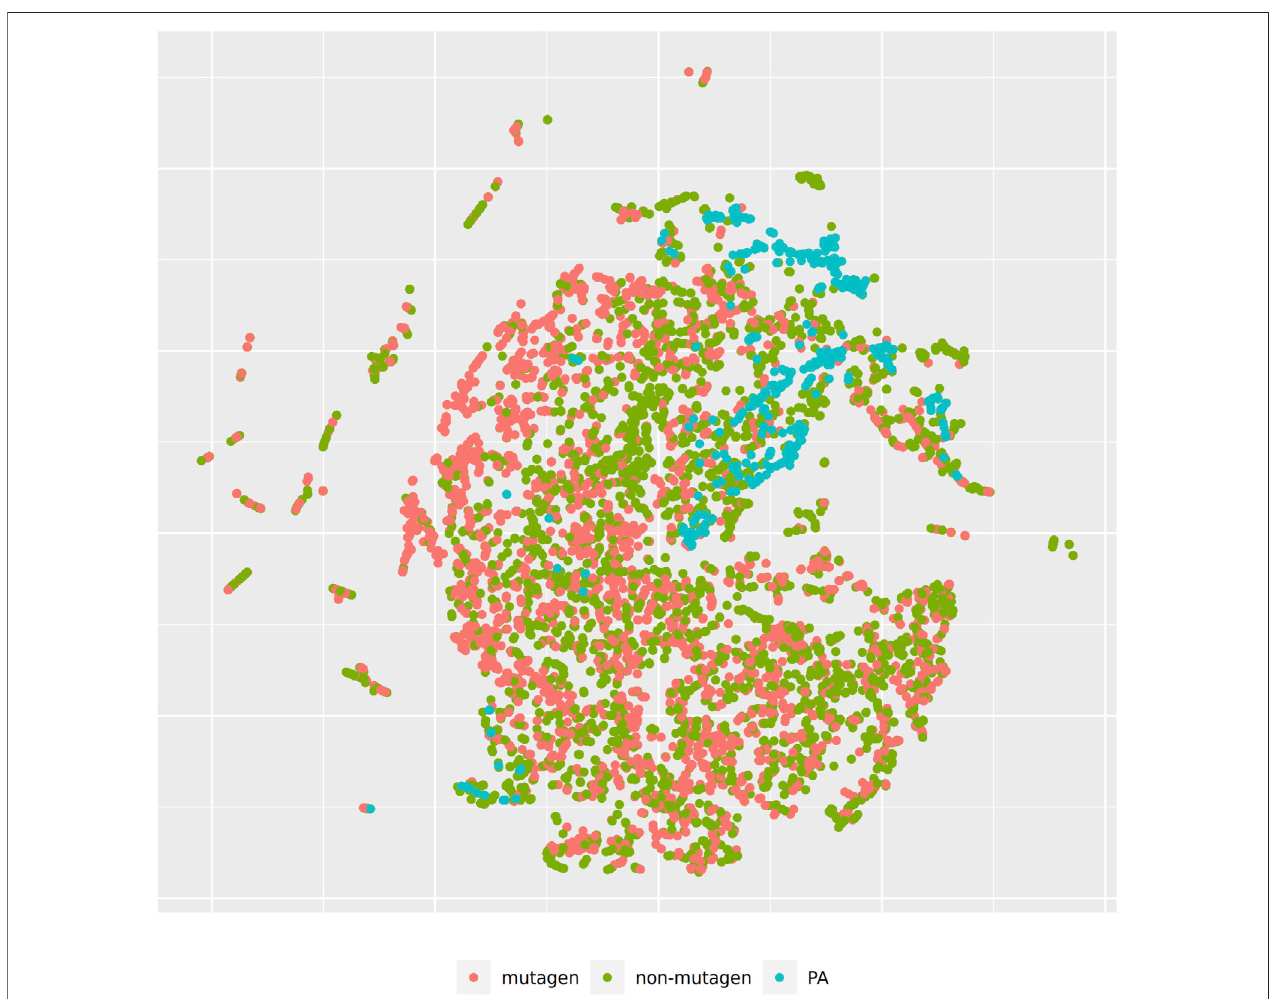
FIGURE 4 | t-SNE visualization of mutagenicity training data and pyrrolizidine alkaloids (PA) in CDK space.